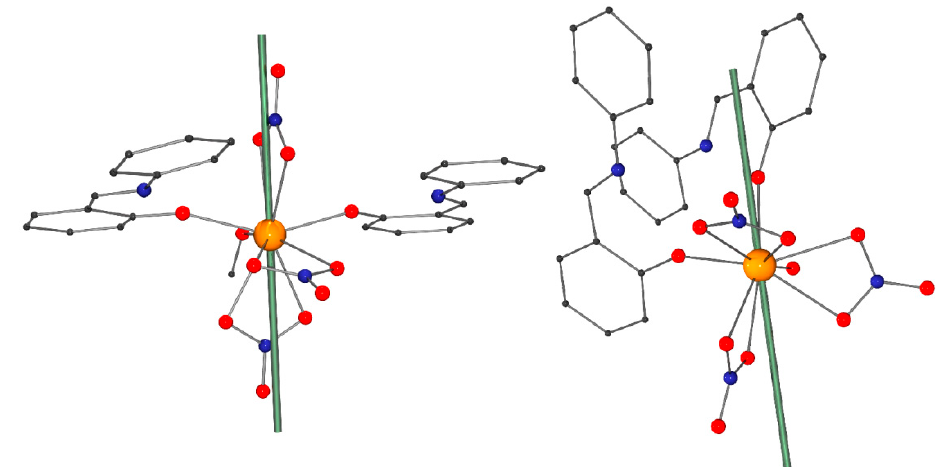
Figure 15. Ground-state magnetic anisotropy axes (green bars) for the Dy III centers in complexes 18 _Dy ( left ) and 7 · MeCN_Dy ( right ).